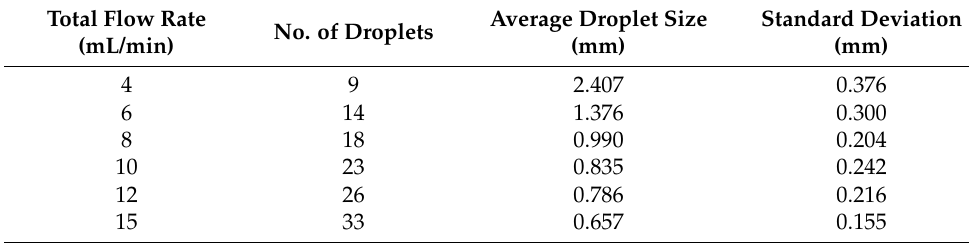
Table 2. Droplet statistics for different total flow rates at q =